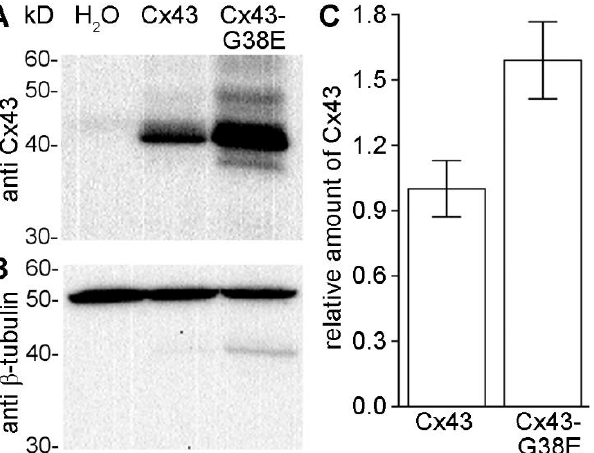
Figure 1. Expression of wild-type and mutant connexins in Xenopus oocytes. ( A ) Western blots probed with an anti-Cx43 antibody showed a prominent 43 kD band in protein samples derived from oocytes injected with wild-type Cx43, or mutant Cx43-G38E RNAs. Oocytes injected with water as a negative control showed no Cx43 signal. ( B ) Re-probing of the blots with an antibody against β -tubulin showed confirmed equivalent loading of total protein in all three samples. ( C ) Analysis of band density revealed that mutant Cx43-G38E was translated at levels ~1.6-fold higher than wild-type Cx43 ( p < 0.05, t -test) Data are plotted as the mean ± SE and are derived from five independent experiments.